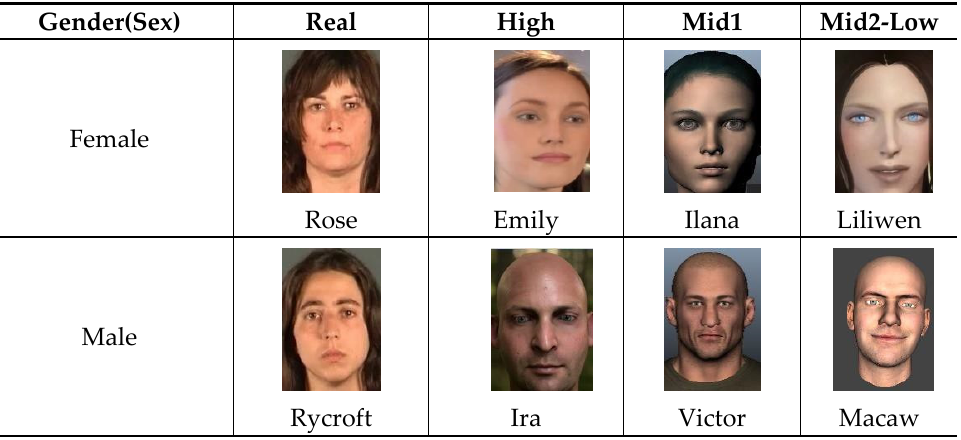
Figure 6. A sample of the avatars used in the experiments.